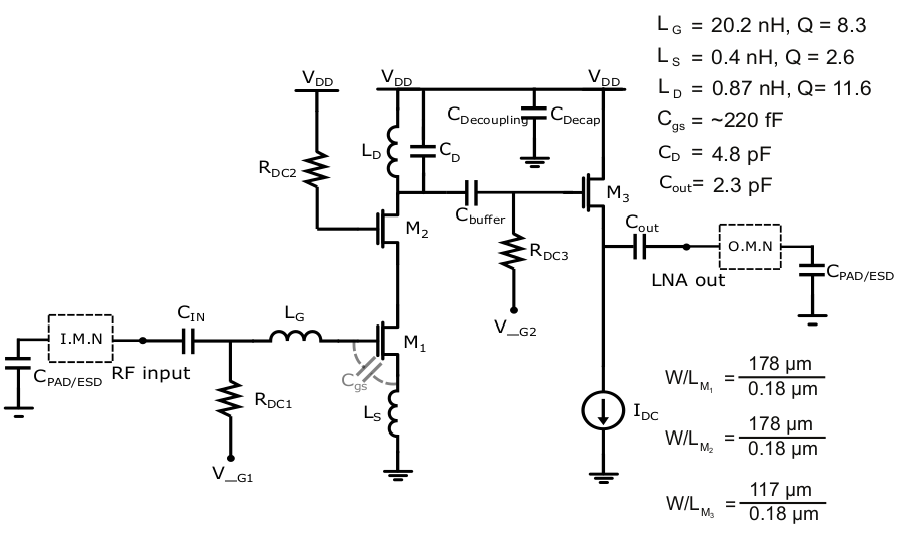
Figure 1. The schematic of cascode amplifier